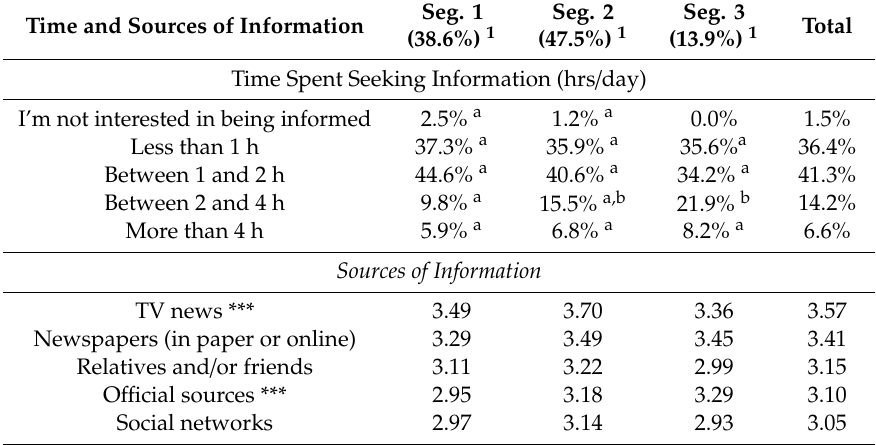
Table 7. Time spent seeking information on COVID-19 (h / day) and preferred sources of information. Time and Sources of